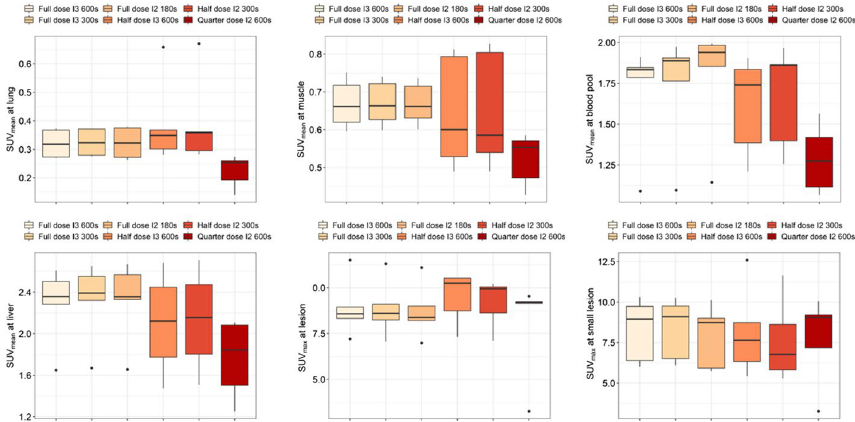
Fig. 6 Comparison of SUV mean at lung, muscle, blood pool and liver, and SUV max at suspected major lesions and small metastatic lesions among six different suggested protocols that involves full-dose, half-dose, and